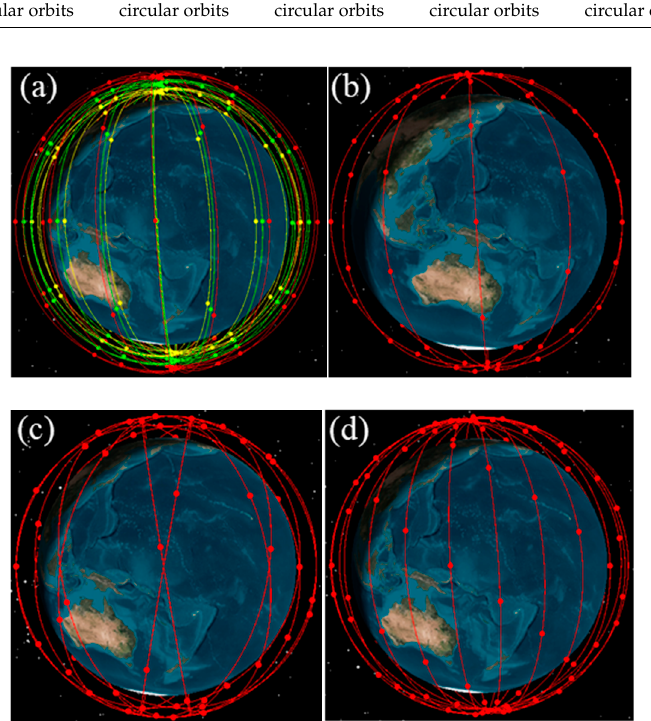
Figure 1. LEO constellations designed for augmented GNSS POD. ( a ) 60 LEO, nearly-polar orbits, 600 km, 1000 km, and 1400 km; ( b ) 66 LEO (Iridium satellite constellation), nearly-polar orbits, 1000 km; ( c ) 60 LEO, sun-synchronous orbits, 1000 km; ( d ) 96 LEO, nearly polar, 1000 km.